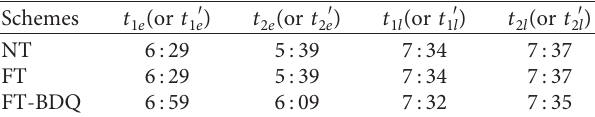
Table 4: Travel time distribution of car travelers and bus travelers under three